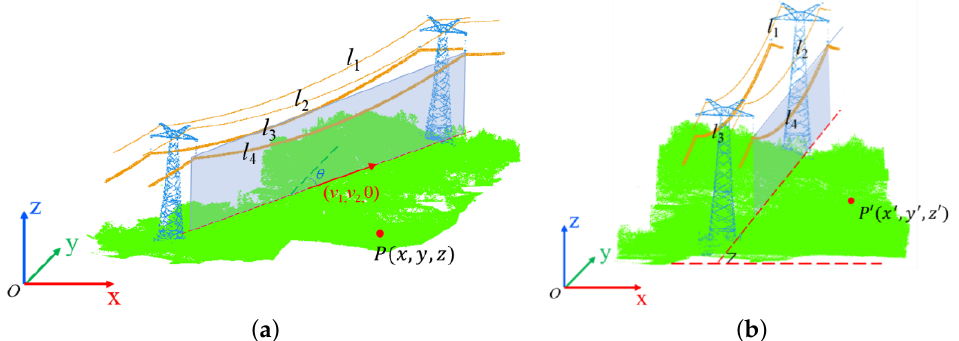
Figure 13. The point cloud scene before and after regularization. ( a ) Original point cloud where the direction of the power line plane is irregular. ( b ) The point cloud after regularization where the catenary plane becomes parallel to the YOZ